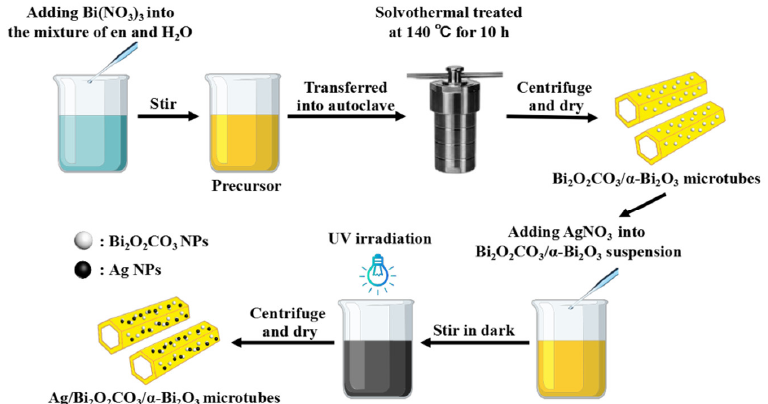
Figure 1. Schematic illustration for the synthesis of Ag NP-loaded Bi 2 O 2 CO 3 /α-Bi 2 O 3 heterostructure microtubes.